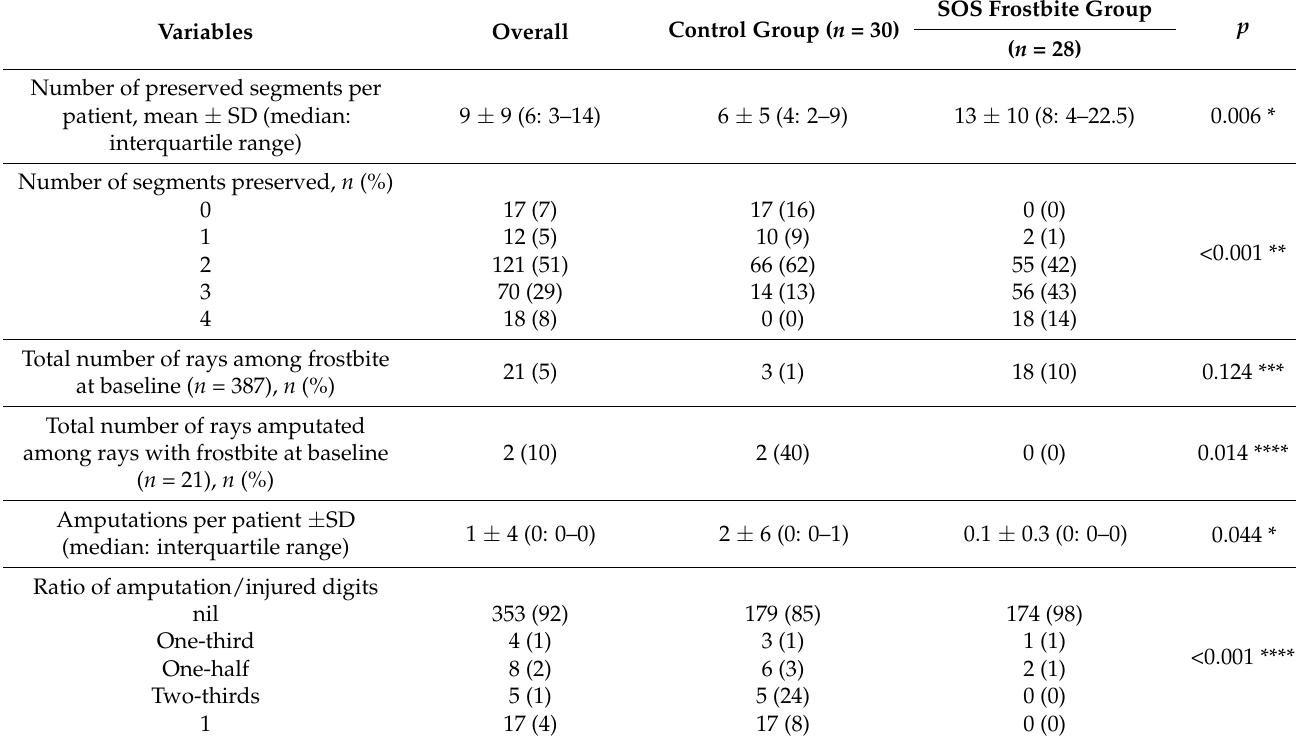
Table 2. Comparison of outcomes between retrospective and prospective cohort studies.